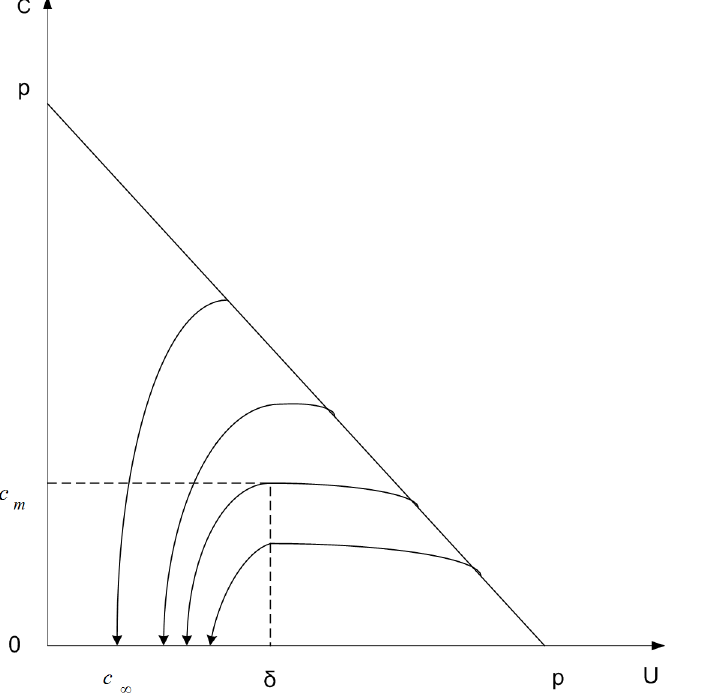
Fig 3. Analysis of phase